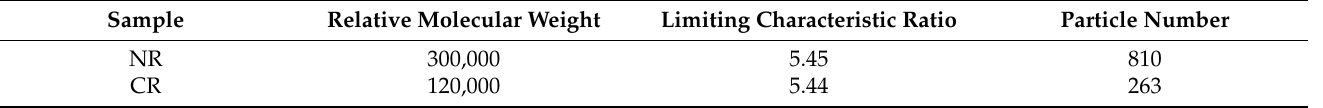
Figure 2. Scheme of NR and CR coarse-grained models. (Green corresponds to one CR molecule, and red corresponds to one NR molecule.) Table 2. Coarse-grained parameters of NR and CR.